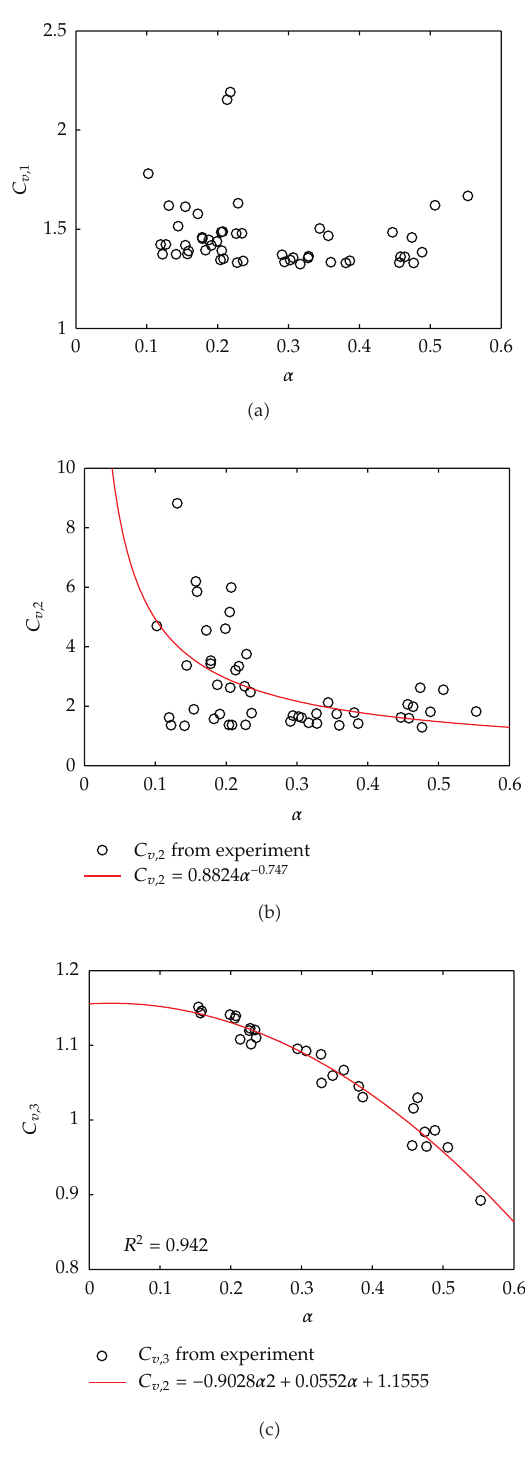
Figure 1: C v,k versus the total void (cid:2) drop (cid:3) fraction α : (cid:2) a (cid:3) C v, 1 , (cid:2) b (cid:3) C v, 2 , and (cid:2) c (cid:3) C v, 3